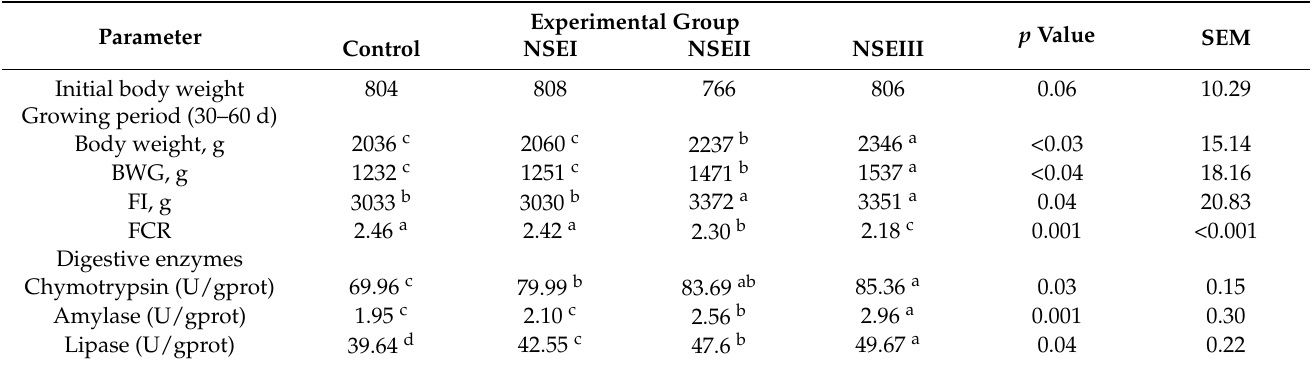
Table 5. Effects of various levels of NSE on rabbits’ growth performance aspects and digestive enzymes’ activities.